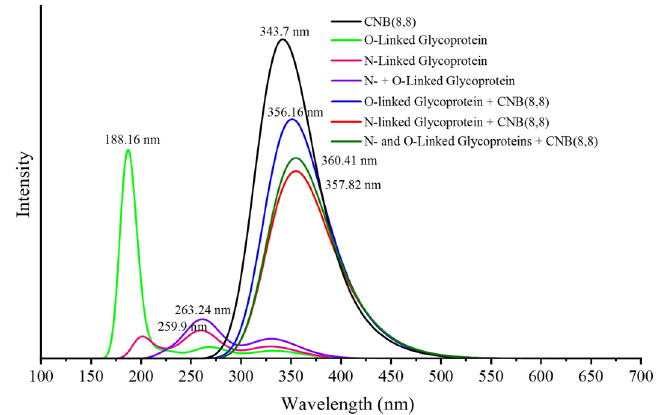
Figure 8. TD-B3LYP predicted absorption spectrum of pristine CNB, glycan molecules, and CNB + glycon complex. As the glycoprotein approaches the CNB, the absorption spectra shift toward the visible